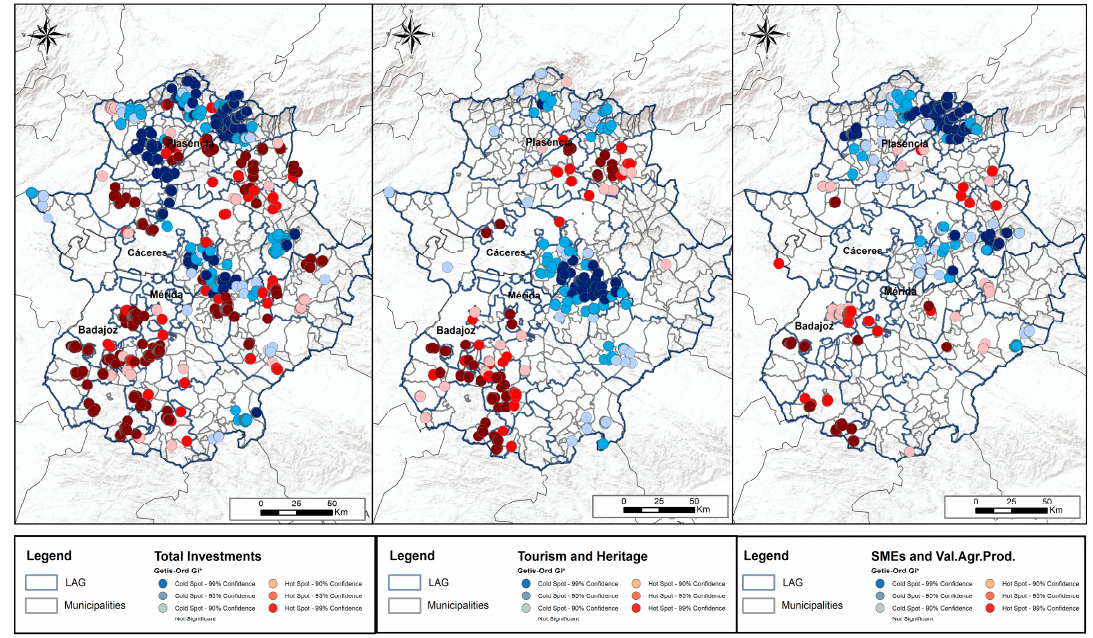
Figure 6. Getis-Ord G i * statistic of LEADER Approach (2000–2013).